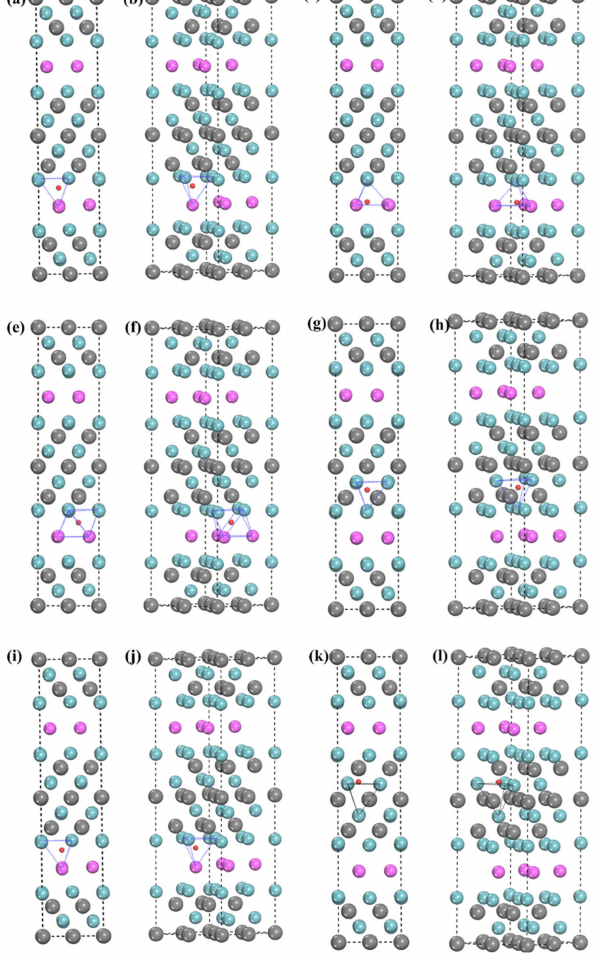
Figure 3. Lowest-energy structures for H incorporation into different interstices of Nb 4 AlC 3 ( a , b ) 1-site; ( c , d ) 2-site; ( e , f ) 3-site;( g , h ) 4-site; ( i , j ) 5-site; ( k , l )